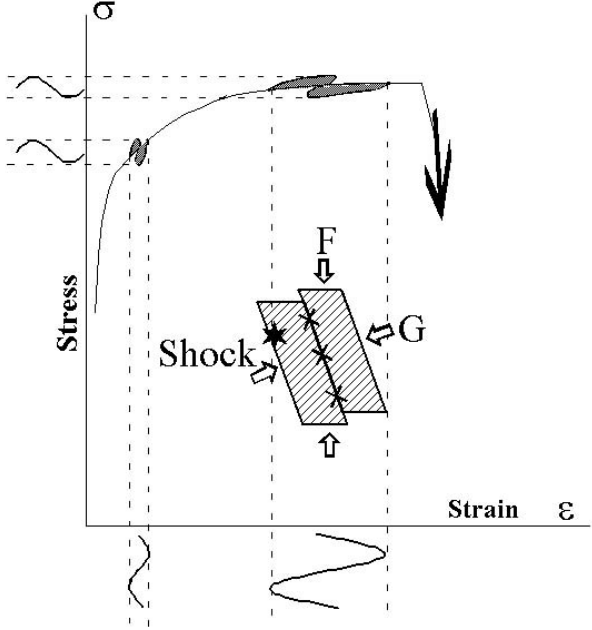
Fig. 19. A rheological diagram σ - ε near the strength limit with the loading arrangement of stick-slip experiment; the star marks the triggering shock; the large arrow marks the time of